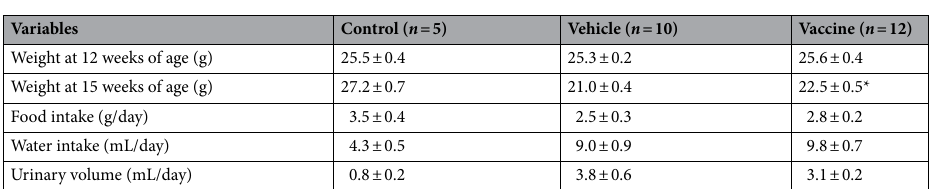
Table 1. Metabolic parameters. Data are presented as mean ± standard error. Student’s t- test was used to compare data between the KLH vehicle and CTGF vaccine group. * P < 0.05.